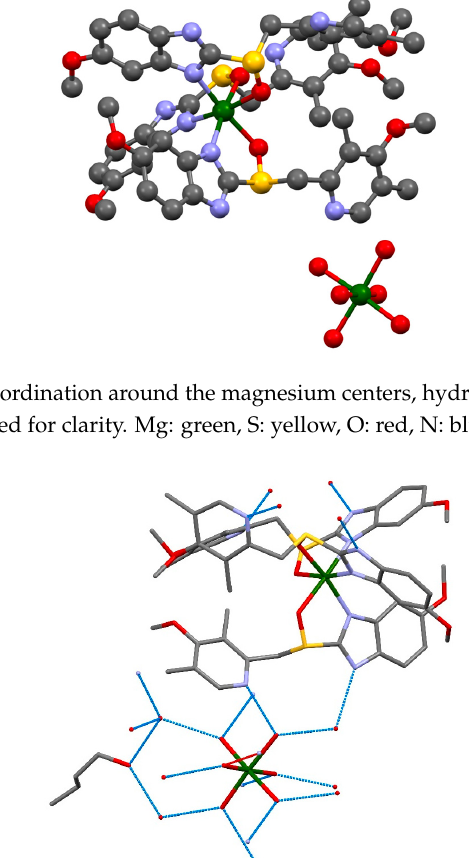
Figure 5. Strong hydrogen bonding between the molecules in the lattice is shown in blue dotted lines; hydrogen atoms have been omitted for more clarity. Mg: green, S: yellow, O: red, N: blue, C: grey.